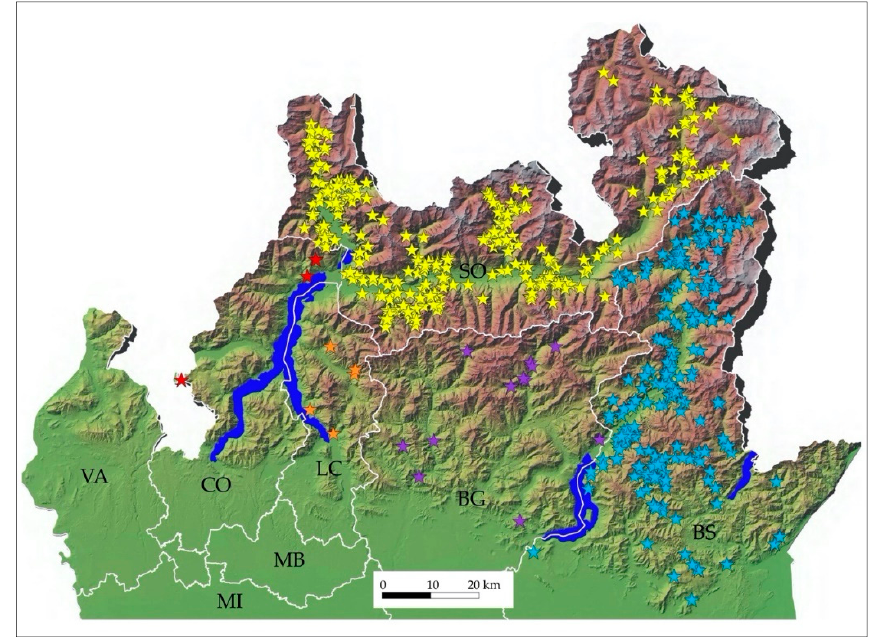
Figure 8. Spatial distribution of instability processes (coloured stars) occurred in the alpine and pre-alpine provinces in the Lombardy Region in the period 1927–2008, for which time of failure was known with sufficient temporal accuracy and daily or hourly rainfall measurements. Provinces: BG, Bergamo ( purple ); BS, Brescia ( blue ); CO, Como ( red ); LC, Lecco ( orange ); MB, Monza Brianza; MI, Milano; SO, Sondrio ( yellow ); VA, Varese.